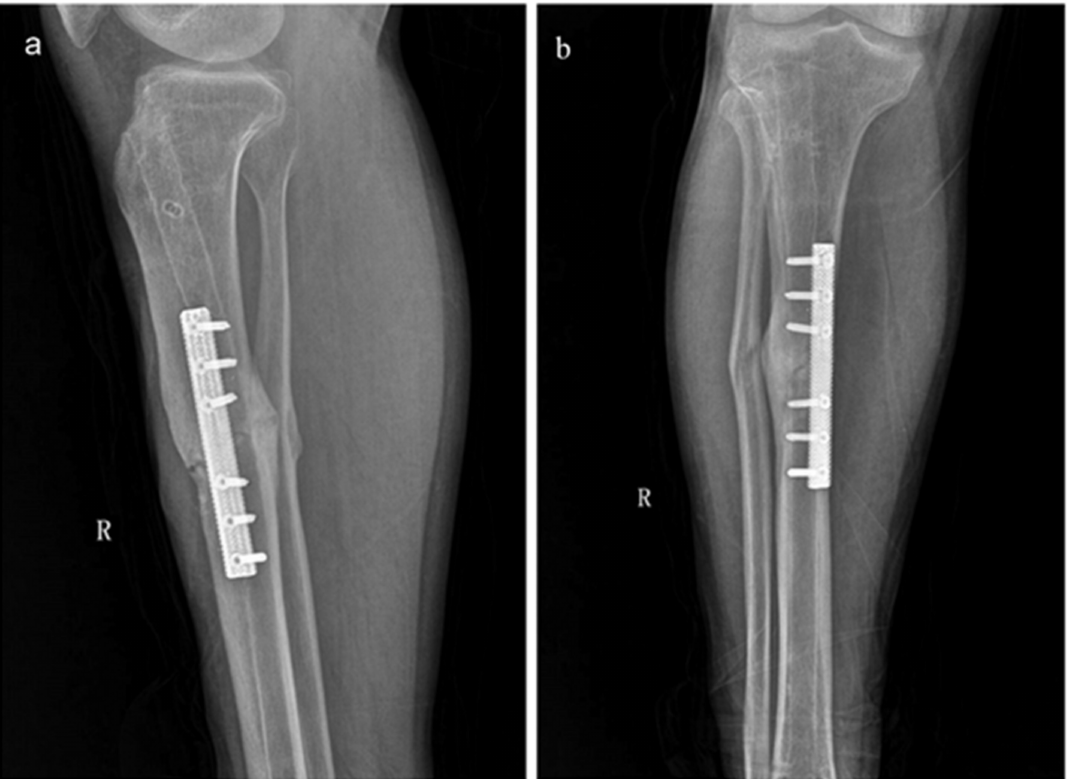
Figure 6. The AP ( a ) and lateral view ( b ) of X-ray examination at 5-month follow-up showed that the fracture healed after the implantation of the printed porous Ta osteosynthesis plate. Reprinted from ref.